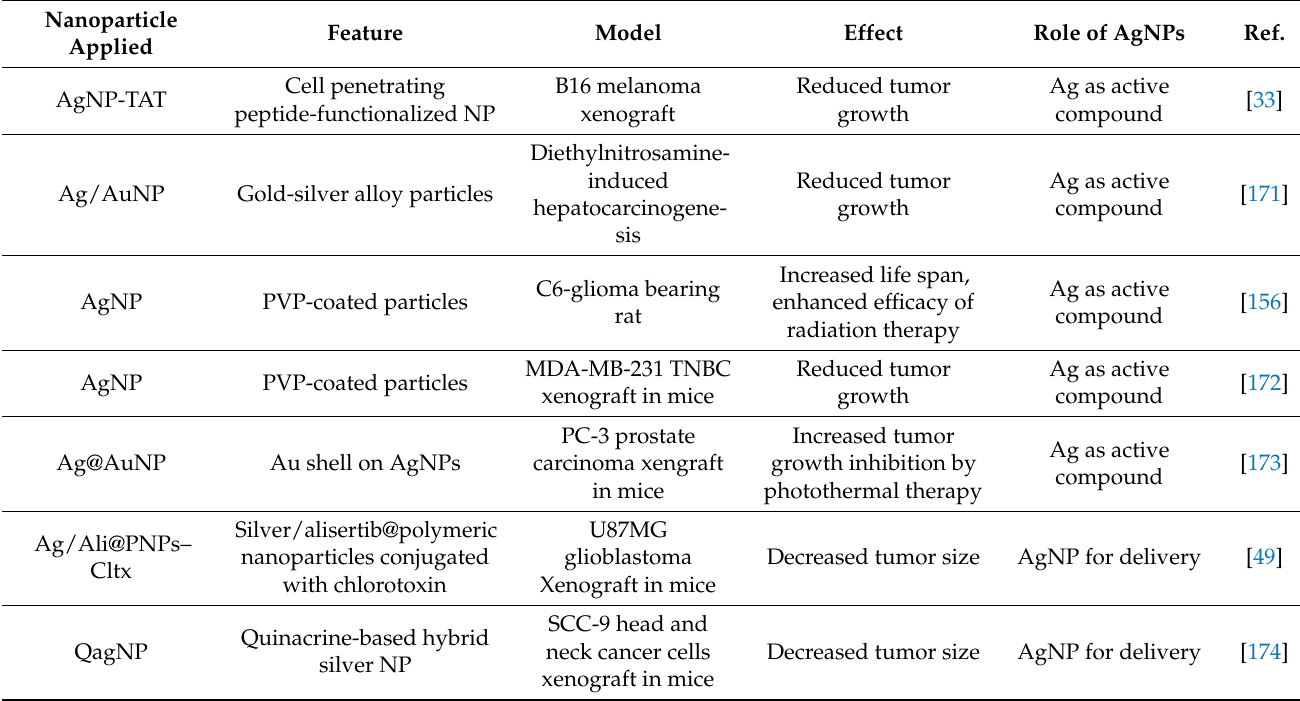
Table 2. Application of silver nanoparticles in in vivo cancer